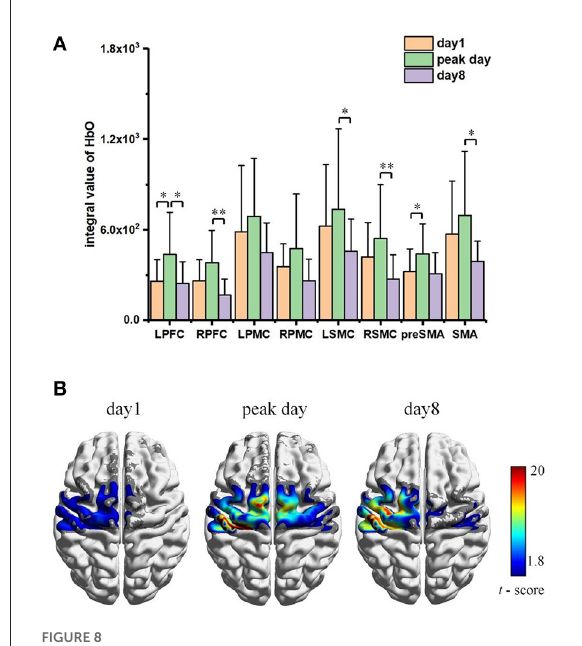
FIGURE8 (A) Averaged Integral Value of 1 [HbO] activation within ROI specific to day1, peak day, and day 8. Significant level: * as p < 0.05 and ** as p < 0.01. (B) Corresponding FC pattern maps, with only statistically significant FC strength are shown ( p < 0.05).